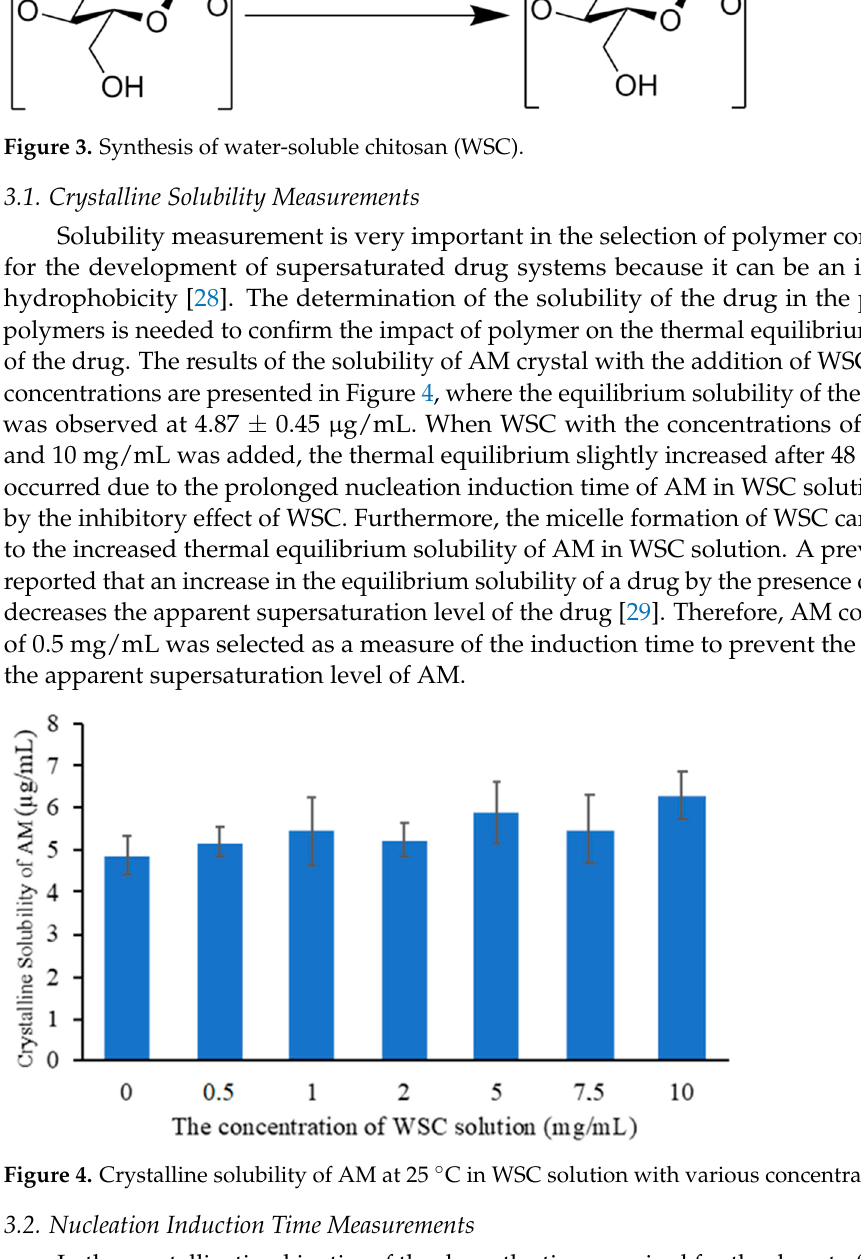
Figure 2. Characteristic diffraction peaks in PXRD of ( a ) alpha-mangostin (AM) and ( b ) water-solu- ble chitosan (WSC).